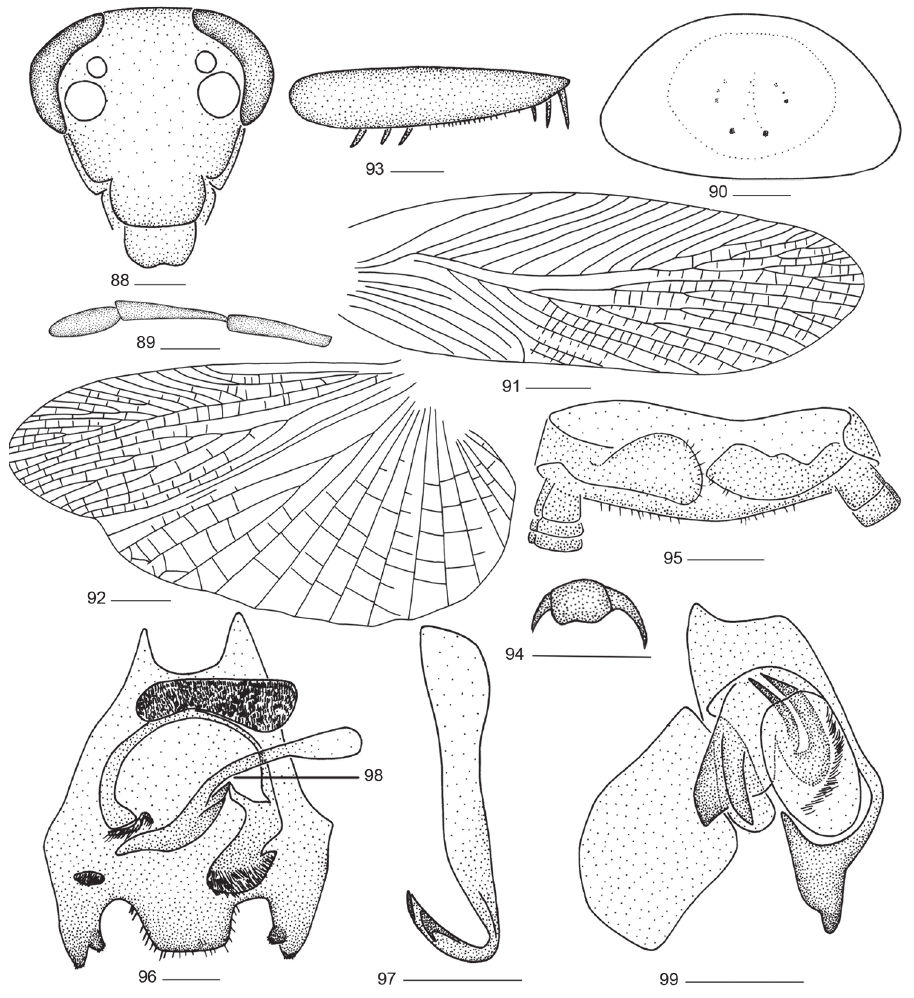
Figures 88–99. Balta valida (Bey-Bienko, 1958) comb. n. 88 head 89 maxillary palps 90 pronotum 91 tegmen 92 hind wing 93 front femur; 94 tarsal claws and arolium; 95 supra-anal plate and paraprocts, ventral view 96 subgenital plate, dorsal view 97 right phallomere 98 median phallomere 99 left phal- lomere. Scale bars: 0.5 mm ( 88–90, 93–99 ), 2.0 mm ( 91, 92 ). with a brush-like structure; base of appendage also with long strip brush-like structure (Fig. 98). Left phallomere complex, with brush-like structure (Fig. 99). Measurements (mm). Overall length male 16.3–20.5, female 14.5–17.0; tegmen length male 14.2–17.0, female 12.0–14.1; pronotum length × width male 2.3–4.0 × 3.3–5.3, female 3–4.3 × 3.3–5.1. Distribution. China (Hainan,